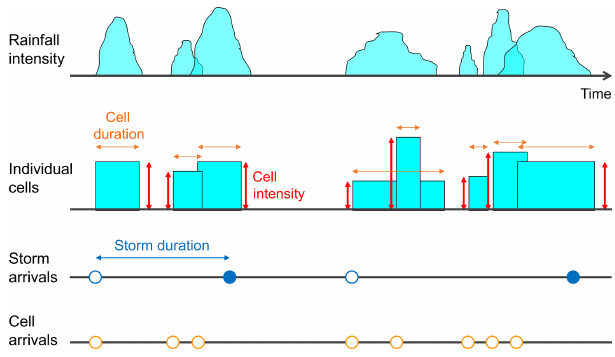
Figure 1. Illustration of the conceptualisation of the Bartlett–Lewis Rectangular Pulse